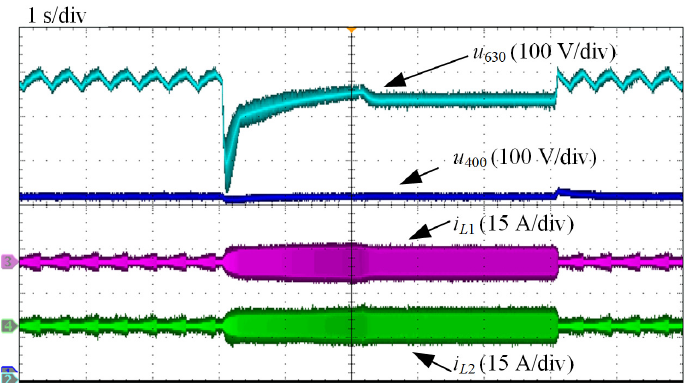
Figure 20. Waveforms of AC load increases from 0 to 7 kW in off-line mode with the original control method.